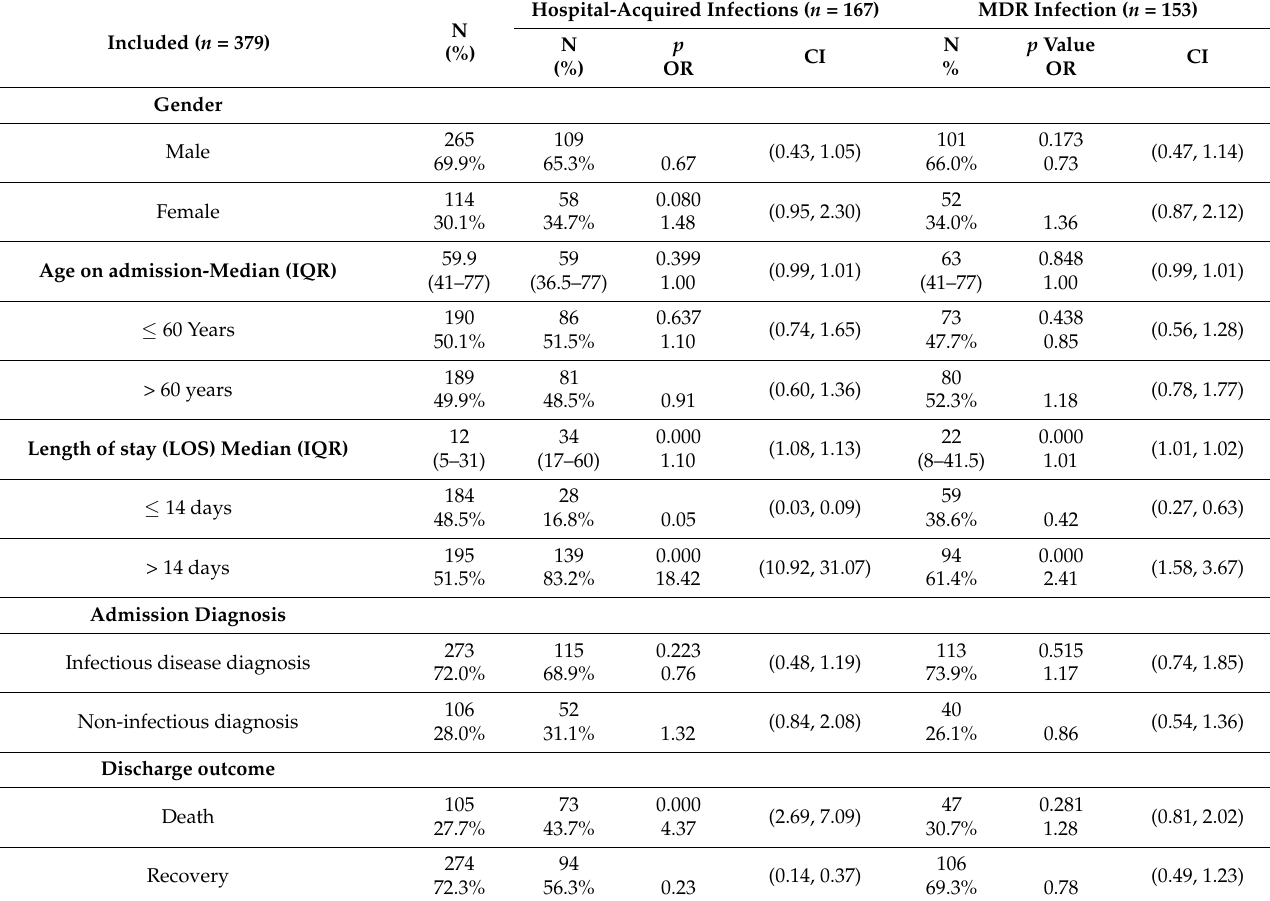
Table A1. Variables related to acquisition of MDR and Hospital-acquired infections. (Binary logistic